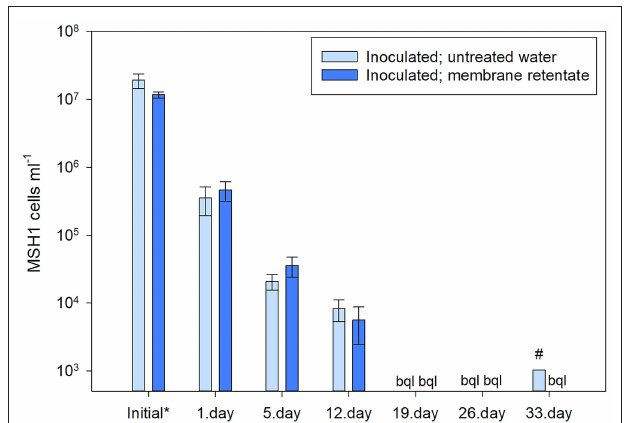
FIGURE 3 | Number of Aminobacter sp. MSH1 cells detected in the outlet of the inoculated columns based on the quantification of bbdA genes. *Indicates the initial loss of MSH1 which was sampled during the first 22h of operation after inoculation and inlet flow of MSNC was started. The rest of the sample times (1–33 days) indicate time after the columns first received untreated (light blue bars) or membrane retentate water (dark blue bars) with BAM. bql: below quantification limit. # only one sample out of three was above quantification limit. Data presented are means with error bars showing standard error.